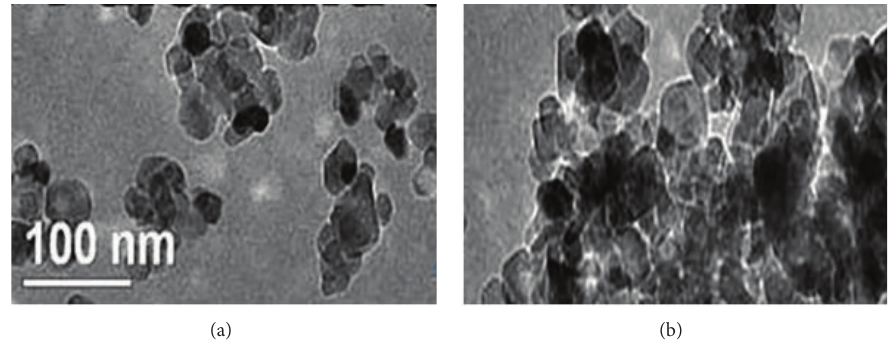
Figure 1: TEM photographs of TiO 2